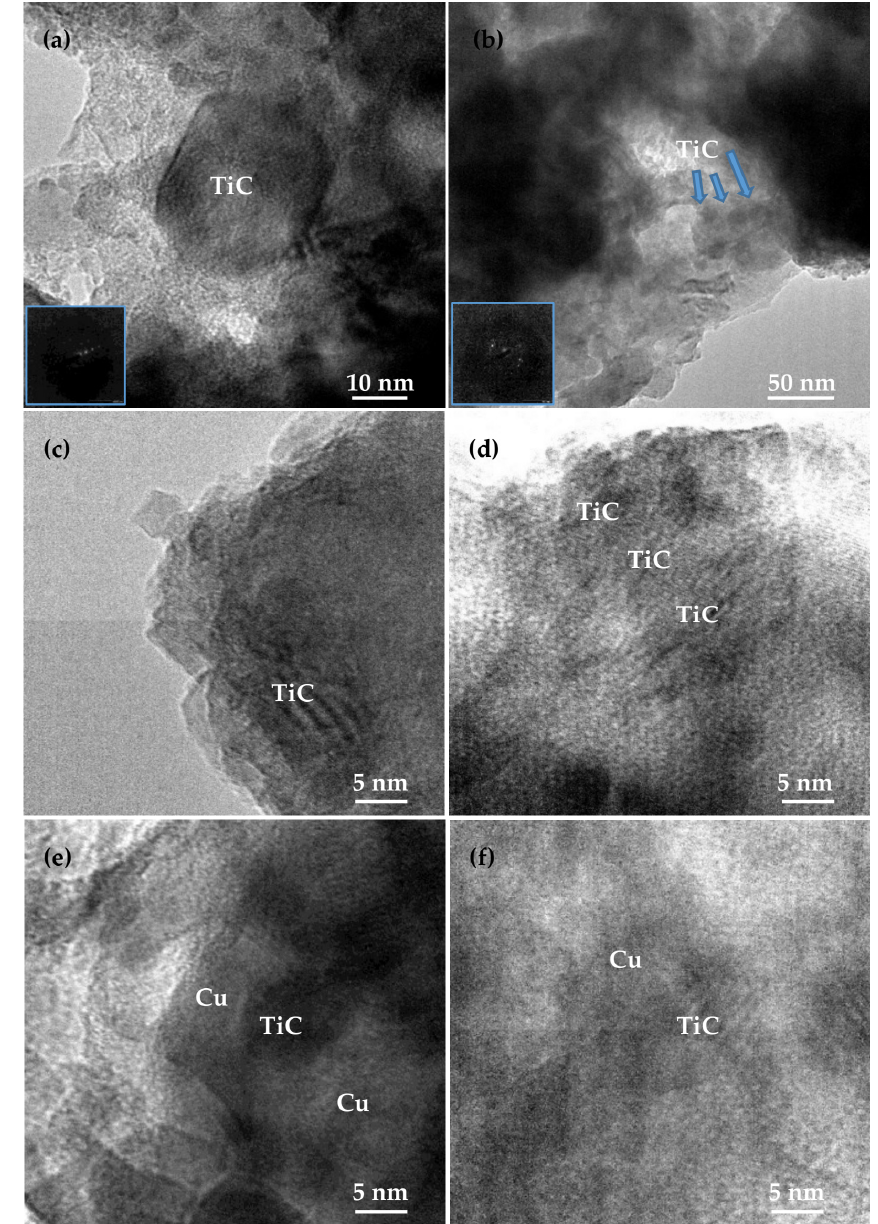
Figure 6. Transmission electron microscopy (TEM) images of ( a ) bright-field image ex-situ composite 5 vol. % TiC sintered at 700 °C (inset: selected area electron diffraction (SAED) corresponding to a TiC phase); ( b ) bright-field image of Cu-TiH2-C composite sintered at 950 °C (inset: SAED corresponding to a TiC phase; ( c , e ) HR-TEM images of ex-situ Cu-TiC composite and ( d , f ) HR-TEM images of in-situ Cu-TiH2-C composite.